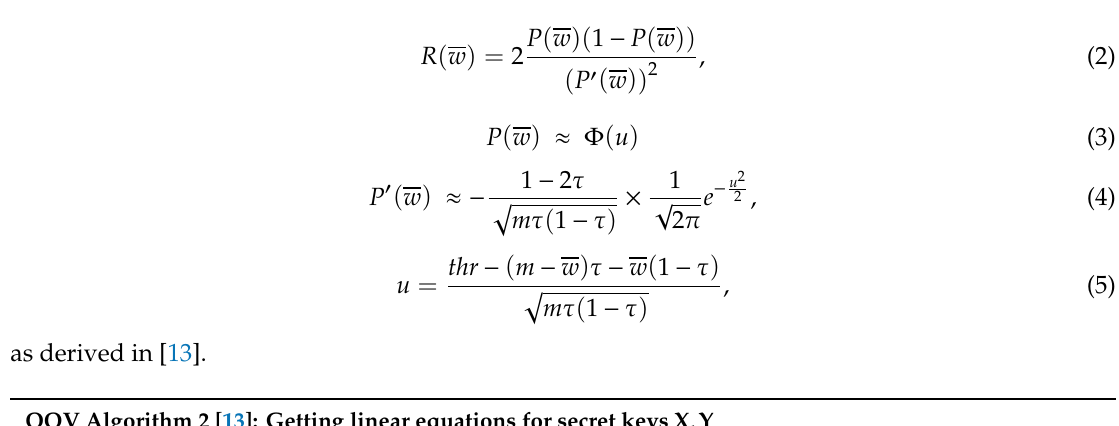
Algorithm 1 uses as input a triplet session between the honest tag and the reader. The output is the Hamming weight of the noise vector e = aX ⊕ bY ⊕ z . The algorithm iterates through n intercepted authentications, where n is big enough to accurately recover w = (cid:107) e (cid:107) . That is, c